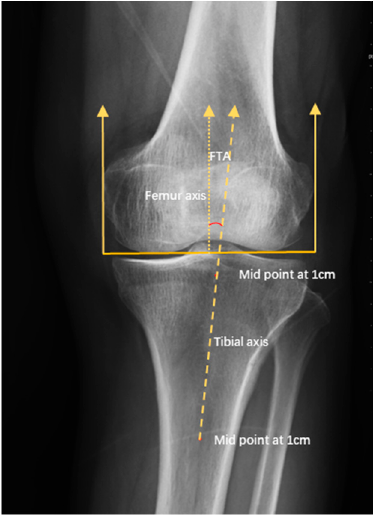
Figure 2. Measurement of the Femorotibial